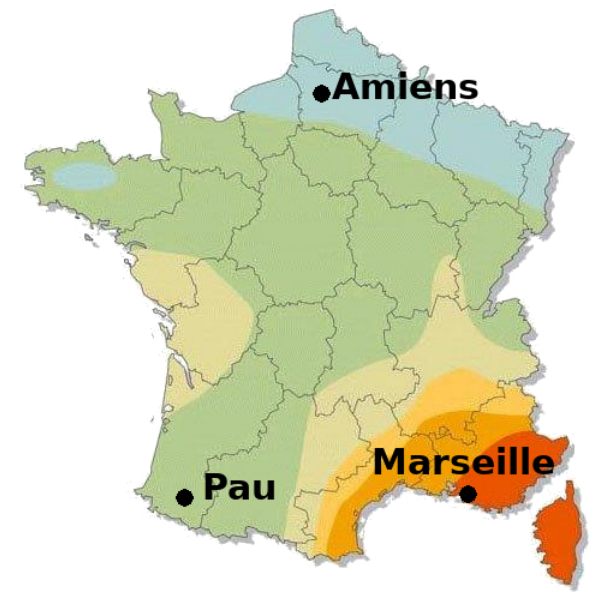
Figure 3. Solar resource in France, according to